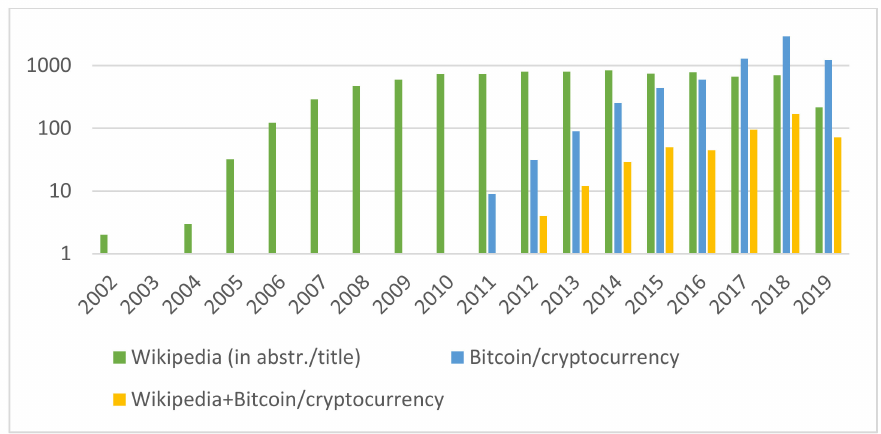
Figure 1. Number of publications in subsequent years (logarithmic